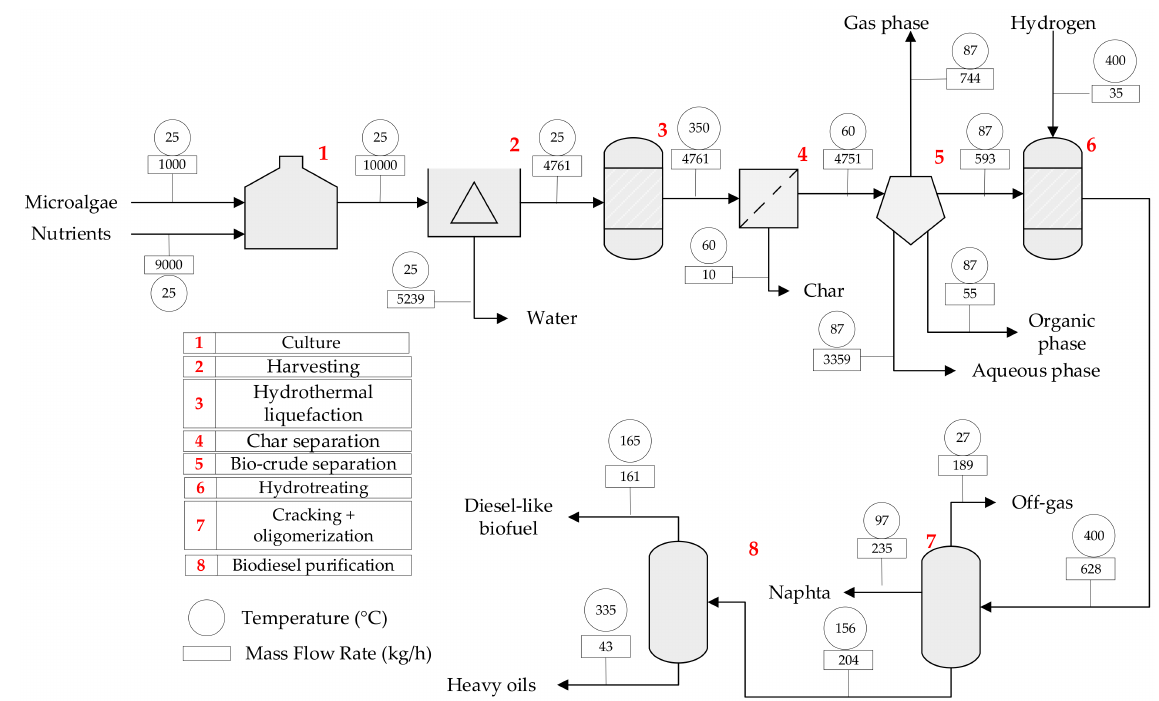
Figure 4. Process diagram for biodiesel production from microalgae via hydrothermal liquefaction